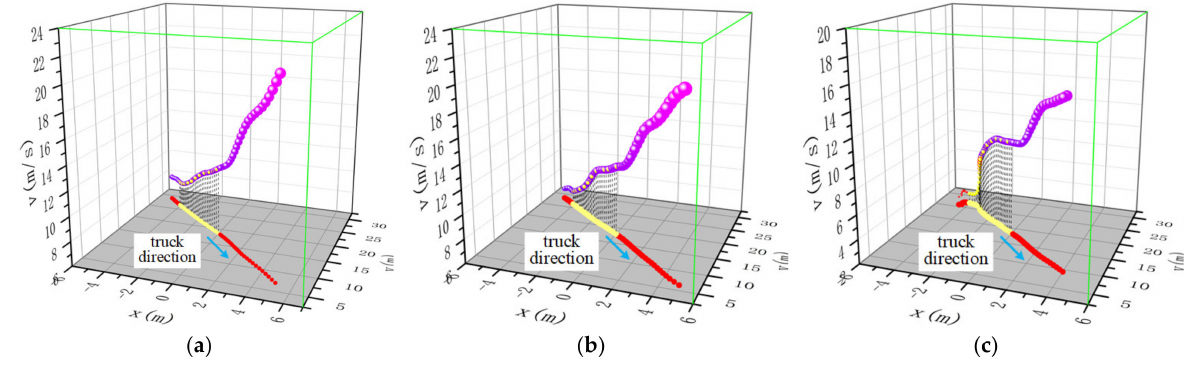
Figure 12. Acceleration state effect diagram. ( a ) No.4; ( b ) No.9; ( c ) No.16.